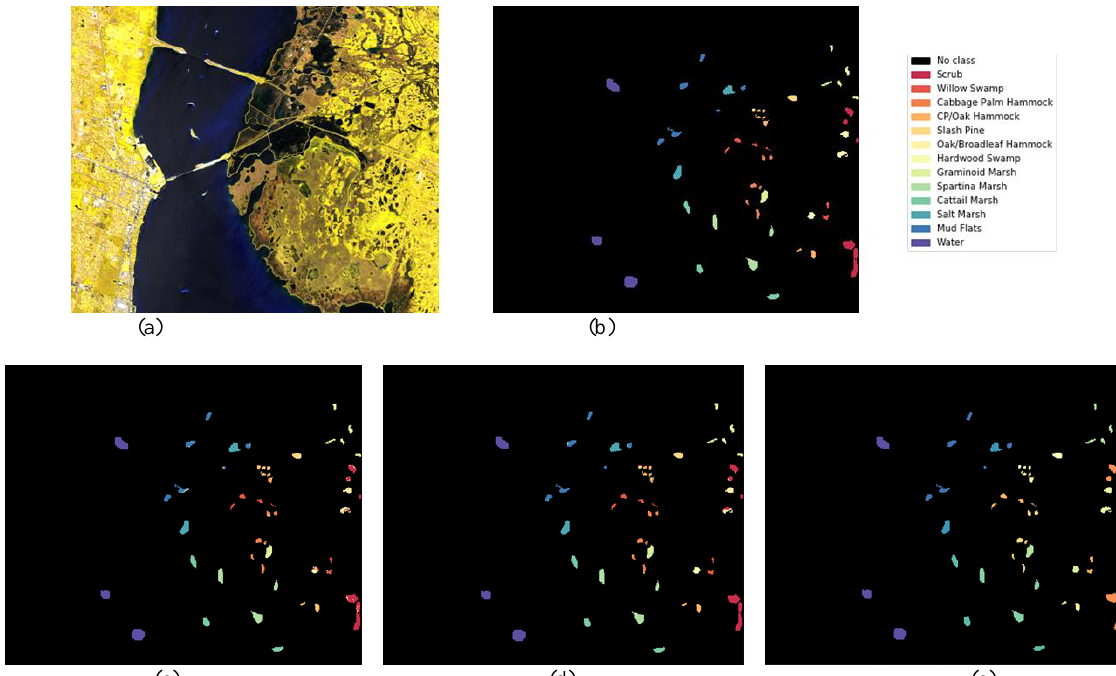
Figure 5. Best classification results of the Kennedy Space Centre scene. (a) FCC. (b) Reference map (c)-(e) classification results by using SAE-LR, CNN, (VAE+CNN)-LR